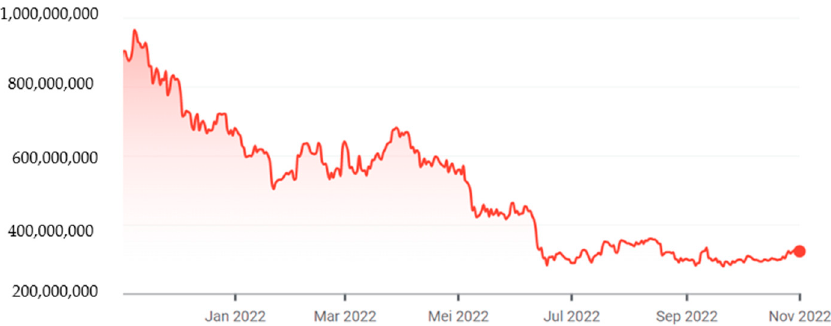
Figure 1. Bitcoin to Indonesian Rupiah from November 2021 to November 2022. Source: Google Finance (2022).